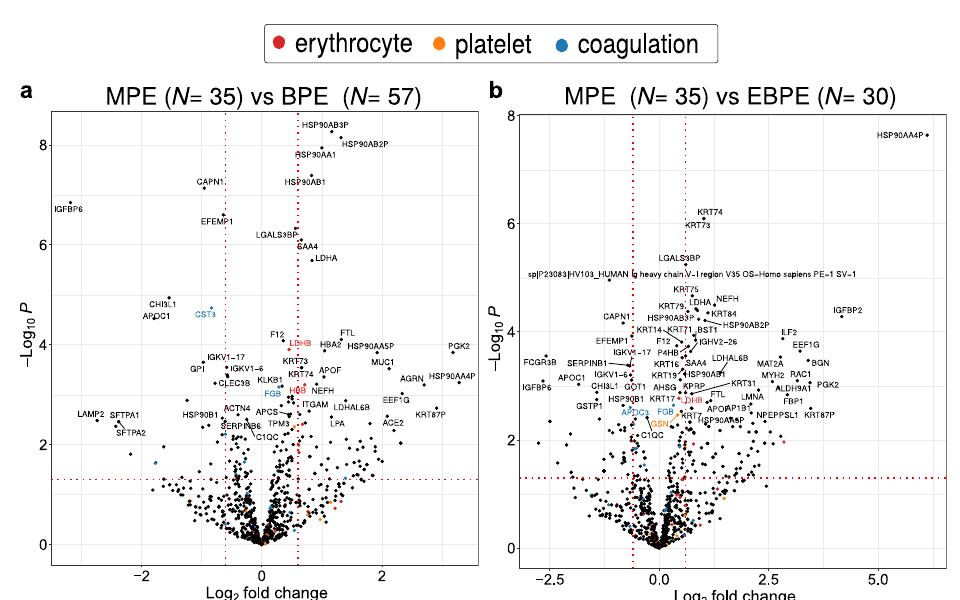
Figure 3. Volcano plot depicting dysregulated proteins when comparing ( a ) MPE versus BPE and ( b ) MPE versus EBPE. The p -value threshold of 0.05 is indicated by a horizontal red dotted line. Red vertical line depicts 1.5 fold up or down-regulation. MPE indicates malignant, BPE all benign and EBPE benign exudate.